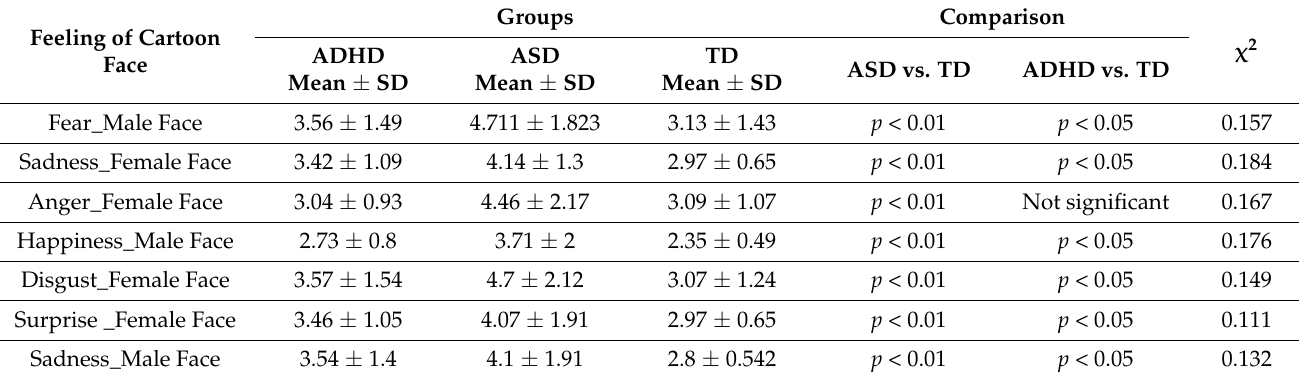
Table 3. Post hoc comparison: diagnostic groups × morphing latency cartoon